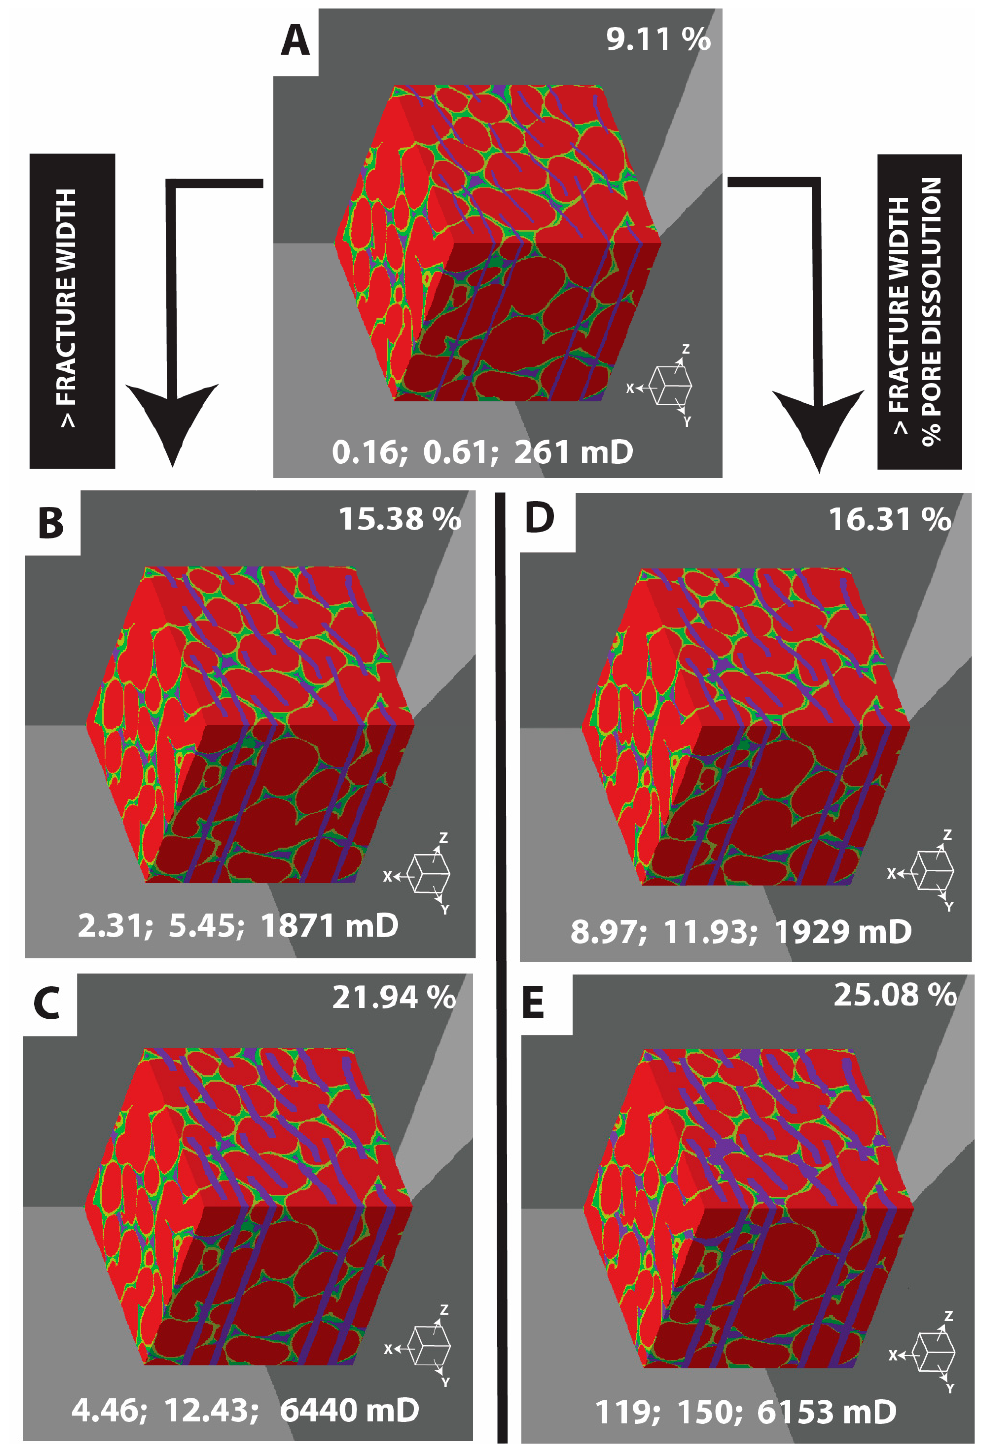
Figure 7. Three-dimensional colourised grayscale models of oolitic limestone, developed from a cartoon based 2D image. ( A ) Model with two phases of cement, and superimposed simple fracture system. ( B ) and ( C ) as in ( A ), but with progressively wider fractures. ( D ) and ( E ) as in ( A ), but with fractures and pores progressively enlarged by dissolution. All images also show recorded porosity (top right), and permeability in the X, Y and Z directions (bottom); with results obtained through the use of the PAT software.